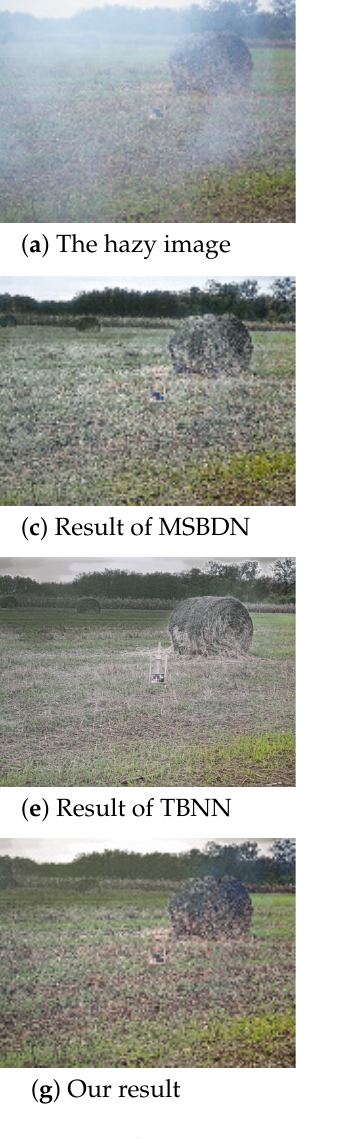
Figure 4. Qualitative comparison of dehazing results on one nonhomogeneous hazy image from NH-Haze (2021)